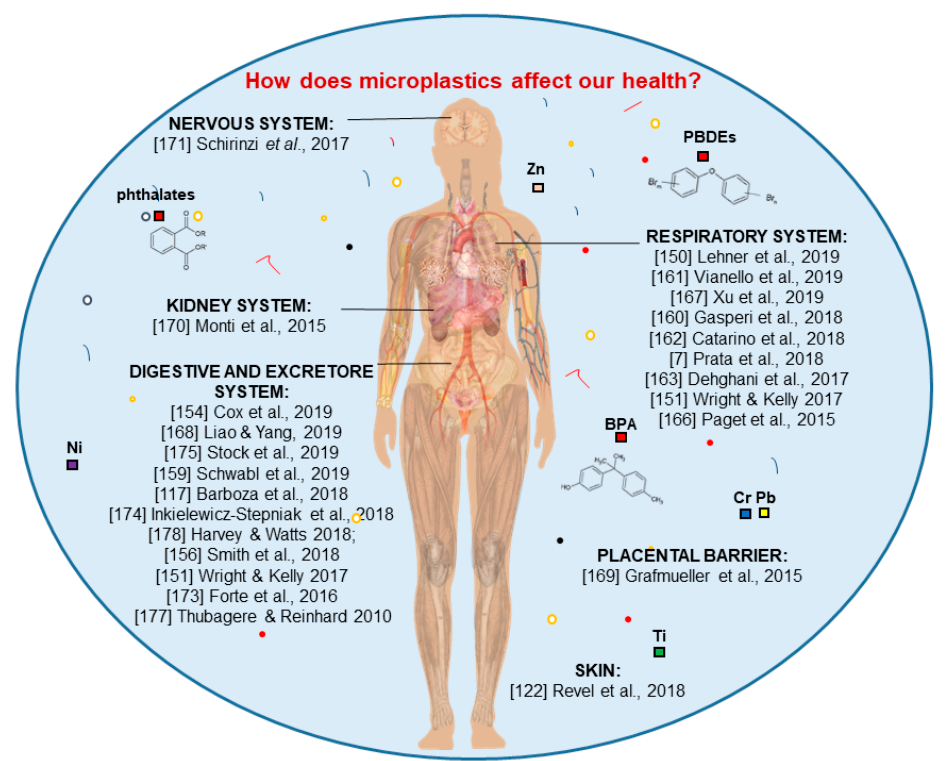
Figure 6. Overview of scientific studies focused on the e ff ects of micro and nanoplastics on human health. Colored squares represent pollutants (organic and inorganic) that could be present in environmental matrices (free or associated with micro and nanoplastics) and that could enter into the human body through di ff erent entry